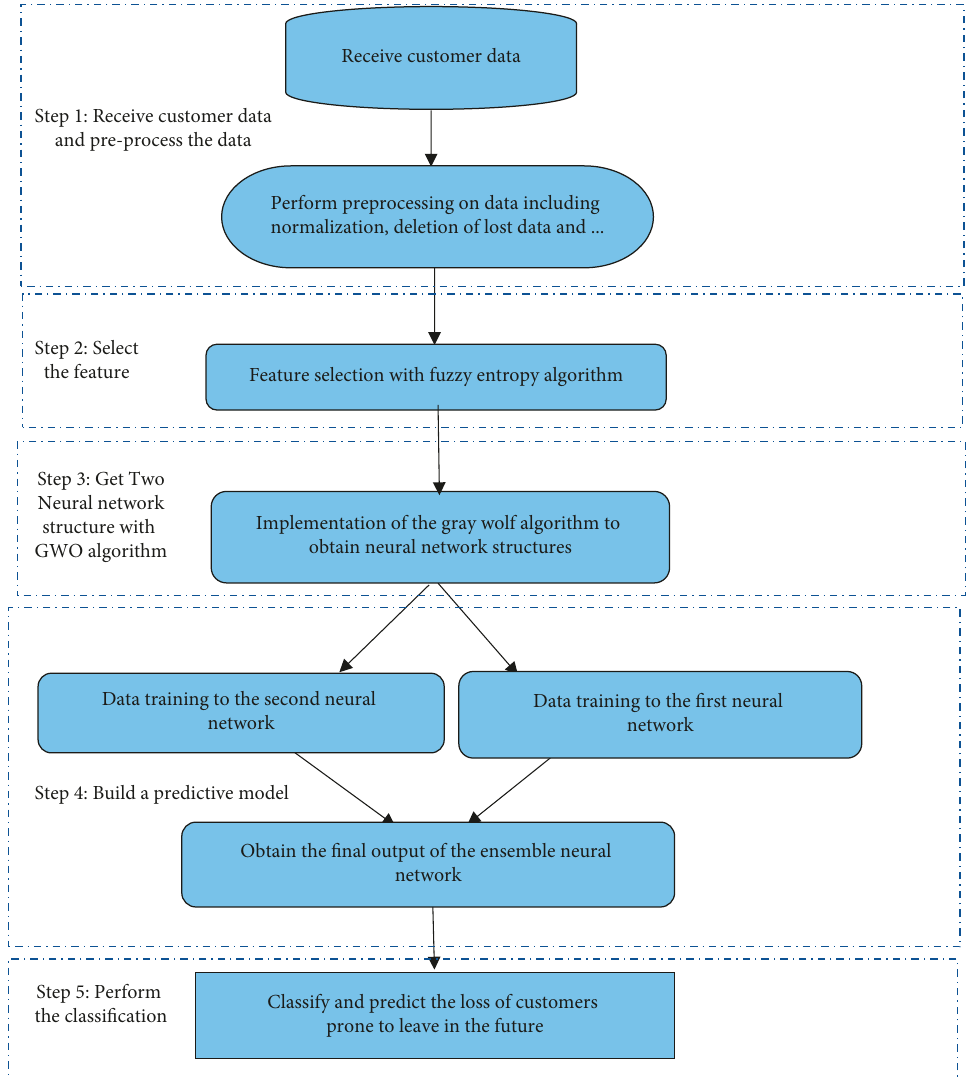
Figure 1: Diagram of the proposed system to predict customer churn.